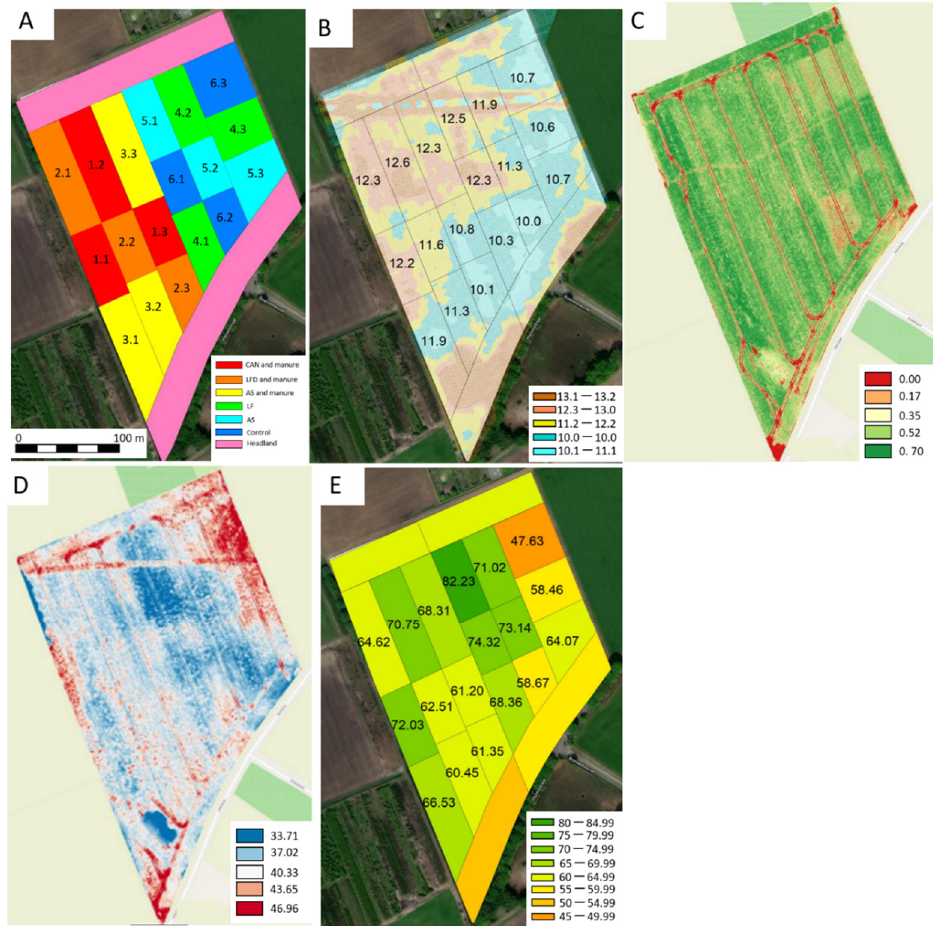
Figure 6. Summary of the field performance during the growing season. The different treatments and repetitions ( A ), the electric conductivity (mS m − 1 ) ( B ), the weighted (near-infrared-red) difference vegetation index (-) measured on 21 June 2020 ( C ), the thermal heat map (°C) measured on 7 August 2020 ( D ), and the average potato yield per plot (t ha − 1 ) ( E ).